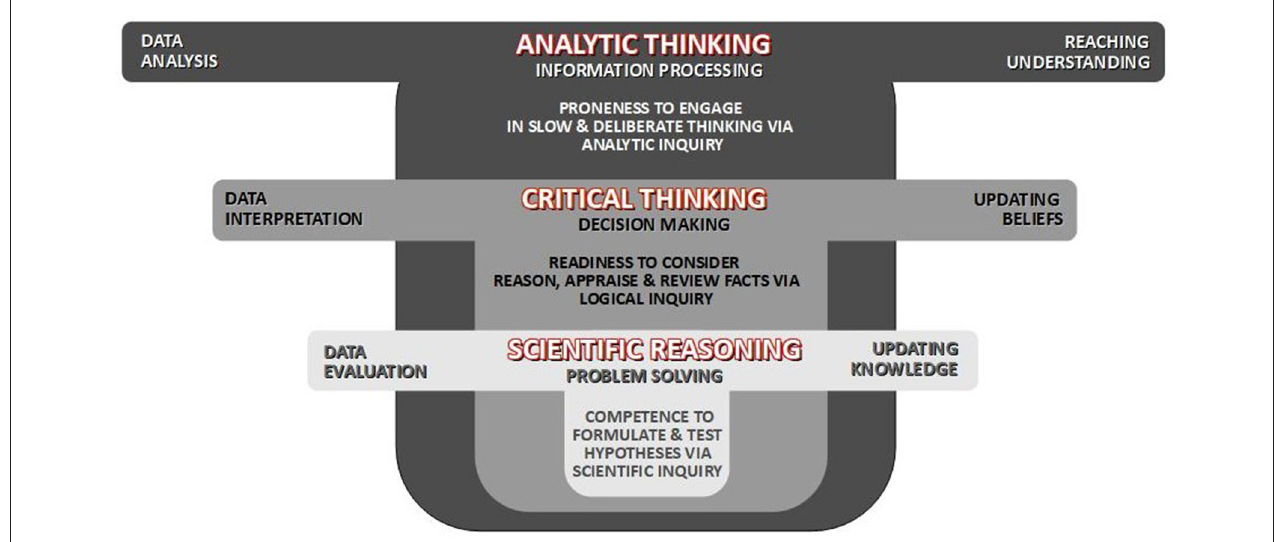
FIGURE 1 | Conceptual framework of cognitive styles: analytic thinking (the broadest and lowest in order), critical thinking, and scientific reasoning (the narrowest and highest in order) are conceptualized as related and nestled